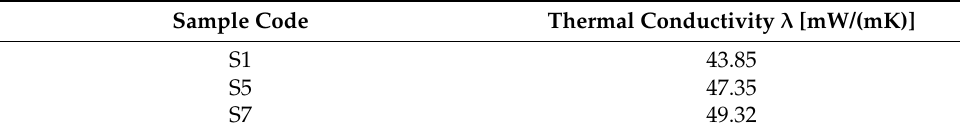
Table 4. Thermal conductivity values of